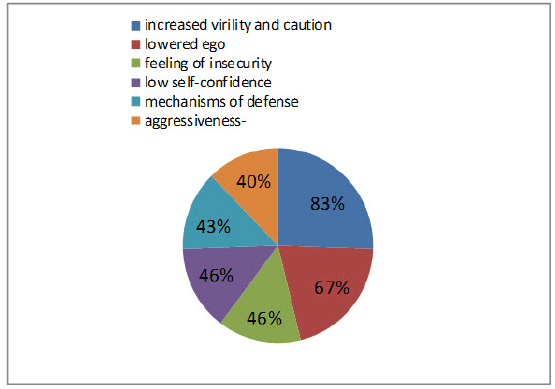
Figure 1. Psychological self-concept in children of divorced